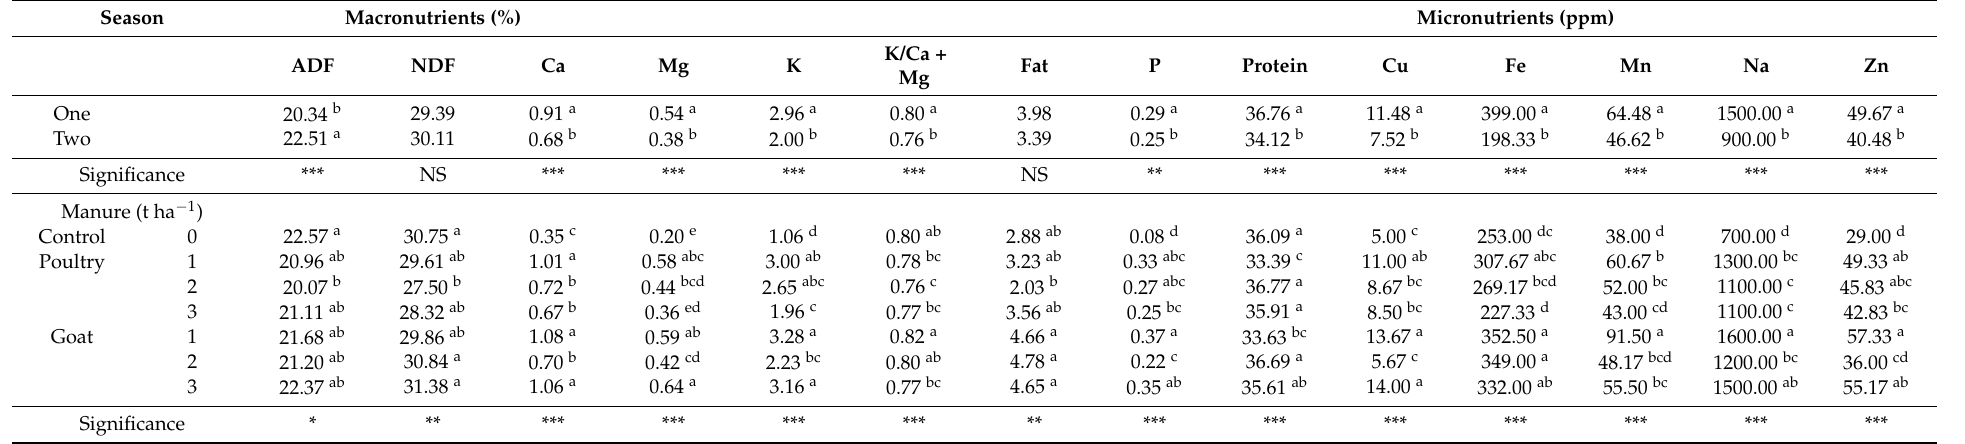
Table 3. Effect of season as well as poultry and goat manure on S. alatum nutrient